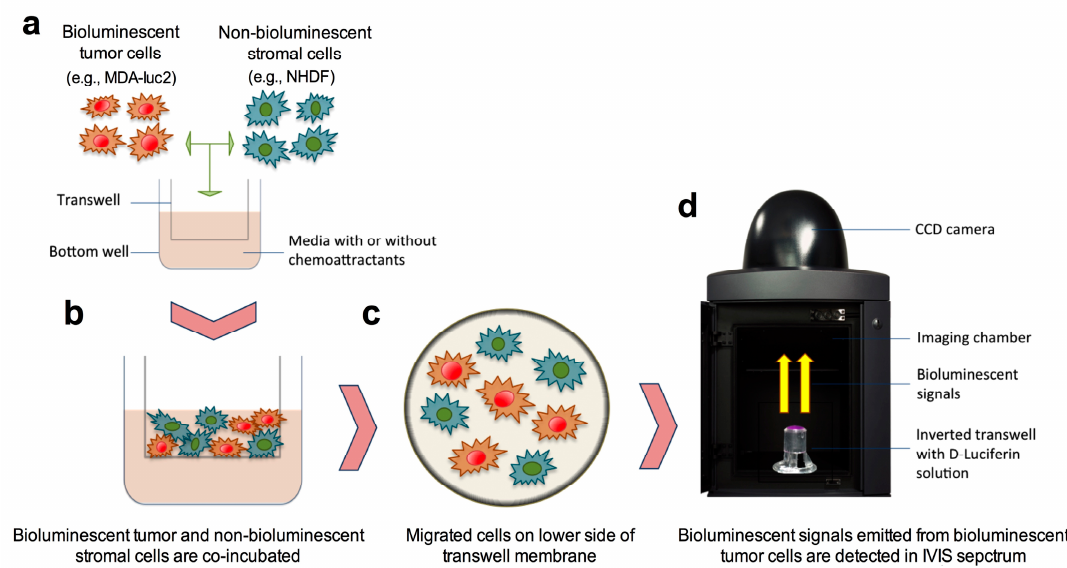
Figure 1. Schematic illustration of the co-incubation of bioluminescent tumor cells and non-bioluminescent stromal cells in the bioluminescence migration assay. ( a ) Bioluminescent tumor cells and non-bioluminescent stromal cells were seeded and ( b ) incubated together in transwells. ( c ) Both bioluminescent tumor and non-bioluminescent stromal cells are likely to have migrated through the membrane. ( d ) Following removal of the nonmigrated cells from the upper side of the membrane, the bioluminescent signal from the migrated bioluminescent tumor cells on the lower side of the membrane are detected by the IVIS® Spectrum, an in-vivo imaging system, after the addition of D-luciferin solution.